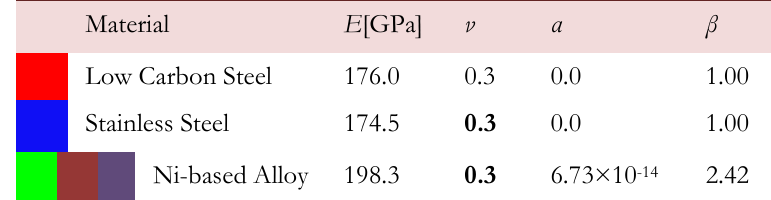
Table 3: Material constants of hot leg materials.